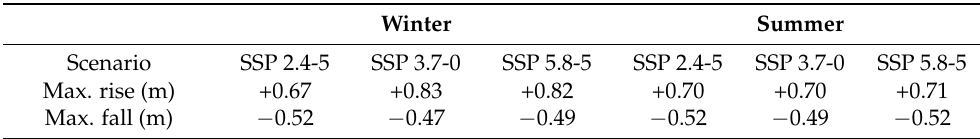
Table 5. Maximum change in the water level (rises and falls) for each of the scenarios compared to the present levels for both winter and